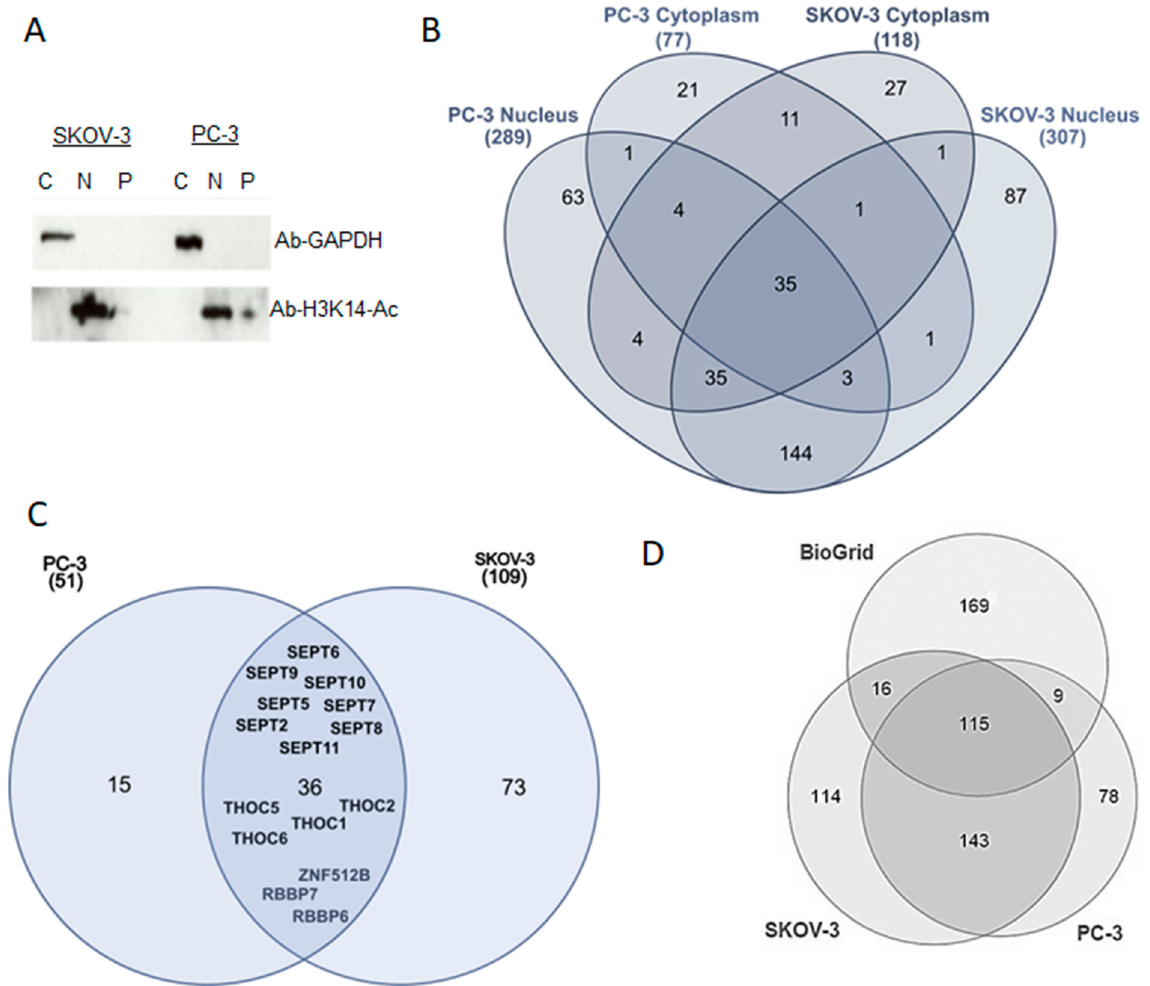
Figure 1. HMGB1 interactome. ( A ) Western blot verification of cellular fractionation of SKOV-3 and PC-3 lysates: nuclear –N- and cytoplasmic –C- fractions and residual pellet –P- were separated in polyacrylamide gels and hybridised against GADPH antibody or H3K14-Ac antibody. ( B ) Venn diagram that summarises the distribution of HMGB1 interactions detected in nuclear and cytoplasmic fractions of SKOV-3 and PC-3 cell lines. ( C ) Venn diagram remarking common interactions detected in SKOV-3 and PC-3 cells. ( D ) Venn diagram showing the intersection of proteins detected in the HMGB1-interactomes with other previously reported HMGB1 binding proteins (https://thebiogrid.org/, accessed on 20 February 2021).